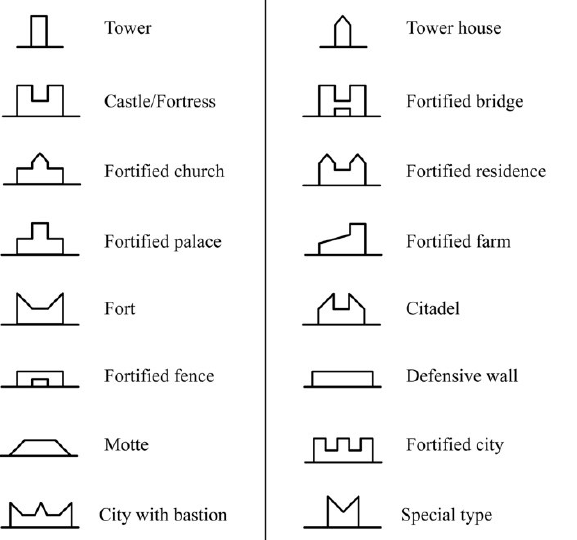
Figure 1. Castle and fortified building typologies from Perogalli and Istituto Italiano dei Castelli (Perogalli C., 1972)